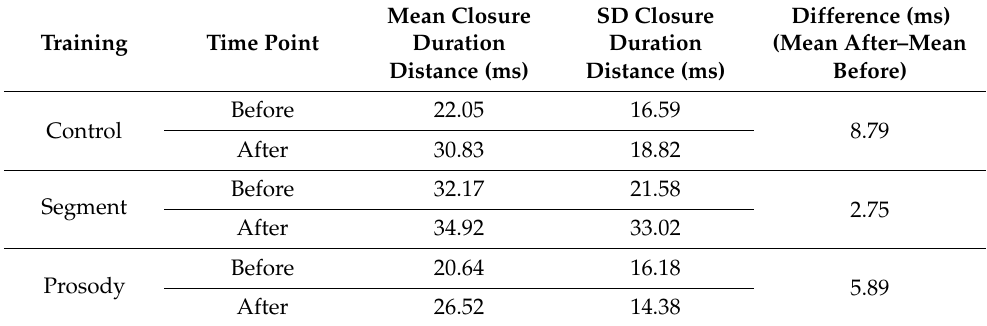
Table 8. Results for closure duration